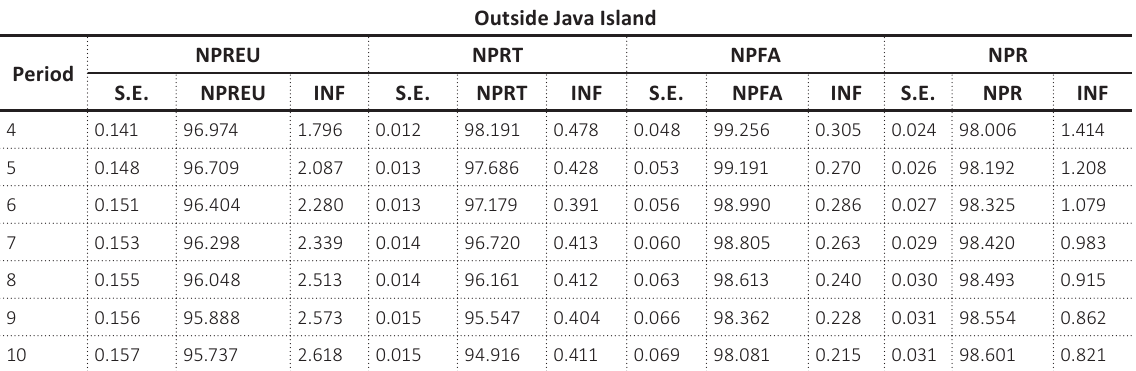
Table 2D (cont.). During the COVID-19